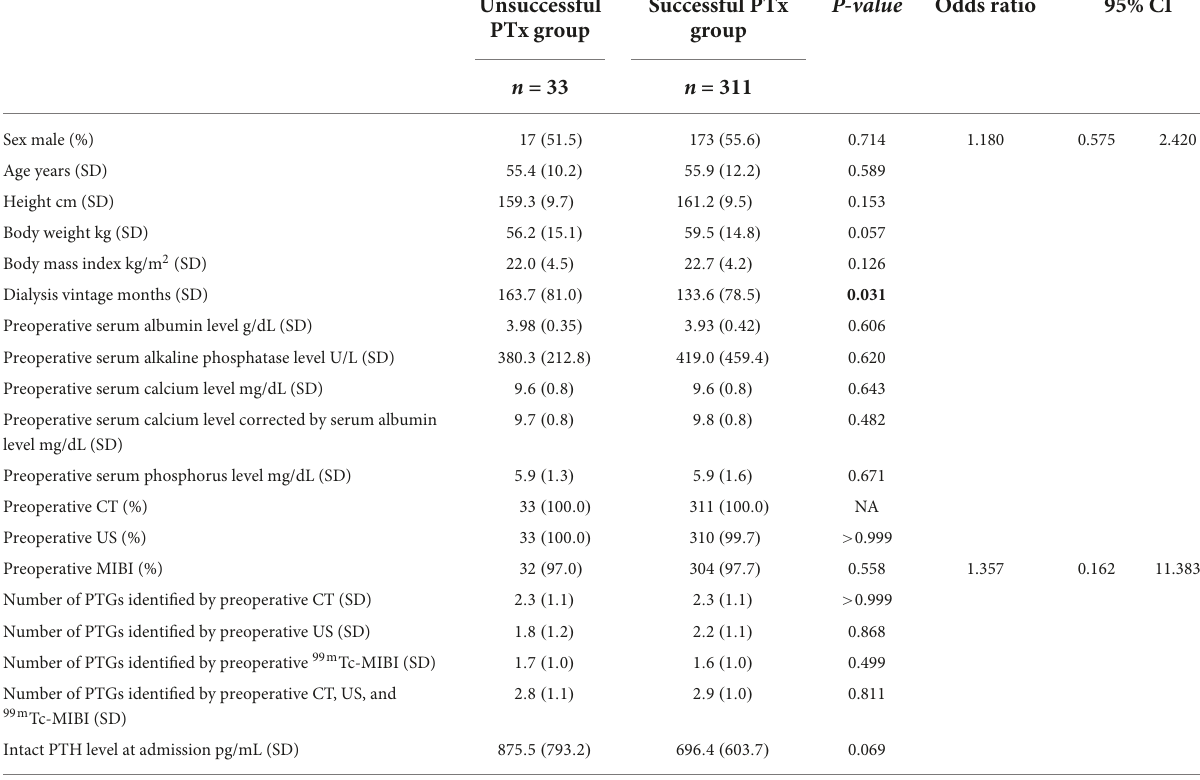
TABLE 1 Patient